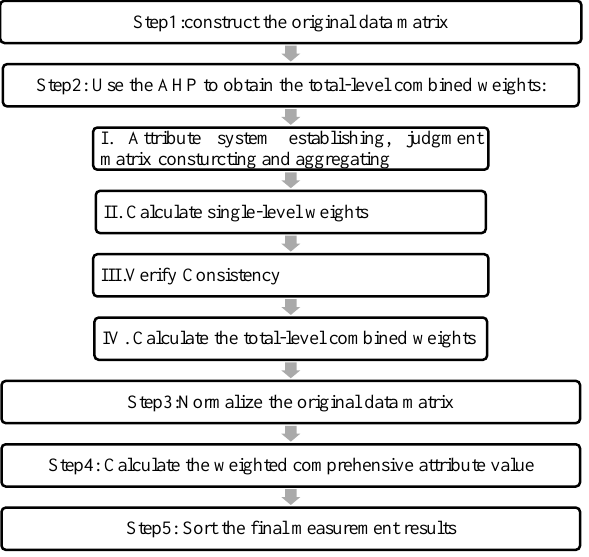
Figure 3. Methodological steps of the AHP-MADM model.